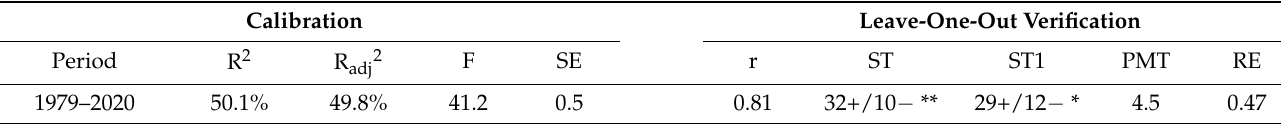
Table 1. Statistics of calibration and validation